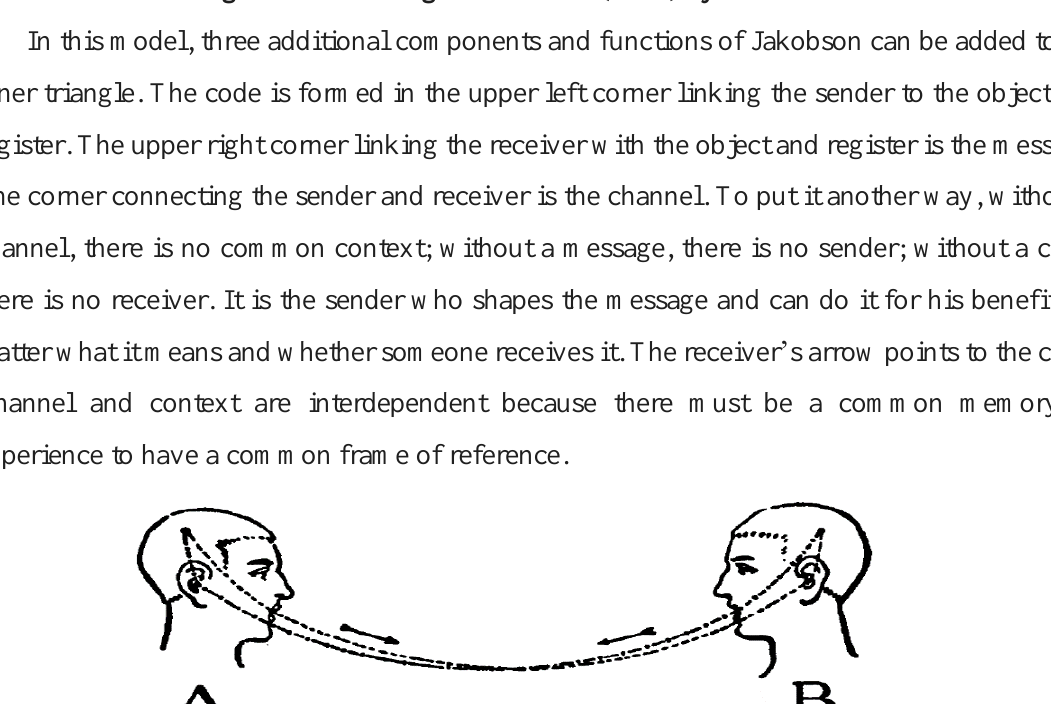
Figure 1: The Organon Model (1934) by Karl Bühler